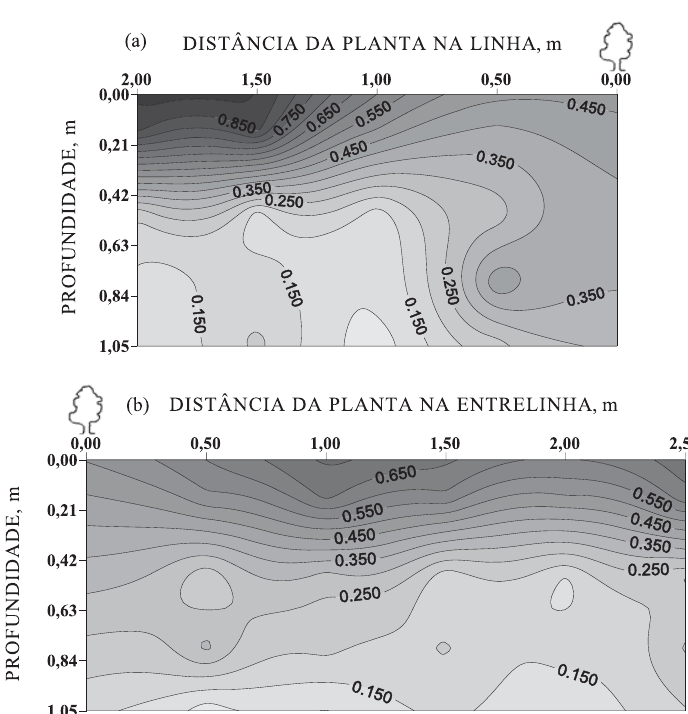
Figura 6. Distribuição espacial da densidade total de raízes da laranjeira ‘Hamlin’ enxertada em limoeiro ‘Cravo”, em cm de raízes por cm -3 de solo, no perfil de um Argissolo Acinzentado (PAC) não coeso, em uma toposseqüência de solos de tabuleiro localizada em Sapeaçu (BA), (a) na linha e (b) na